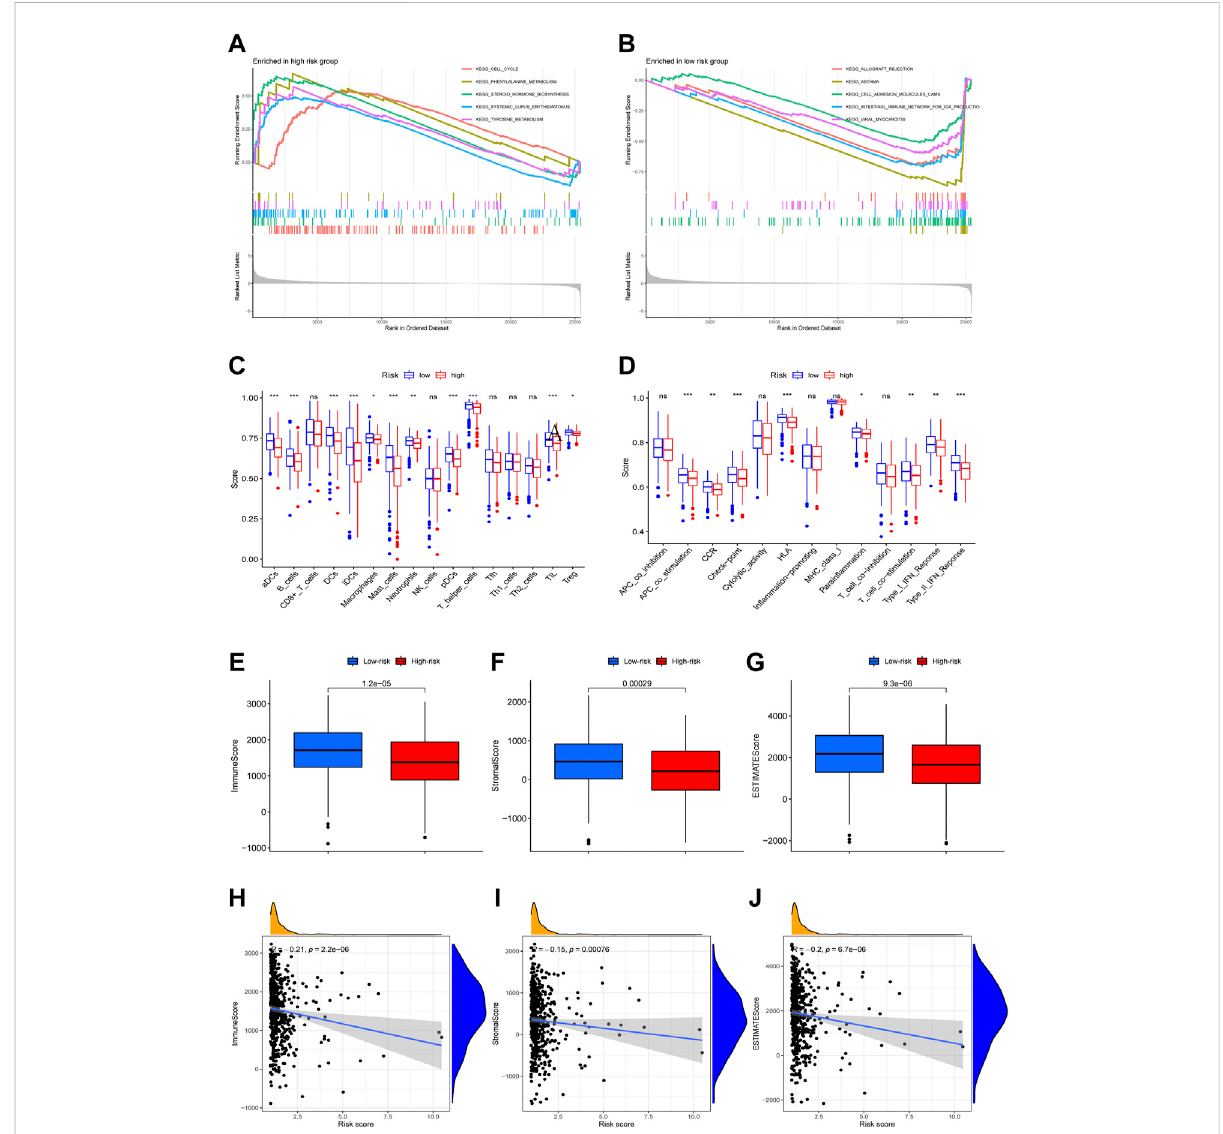
FIGURE 5 GSEA, ssGSEA and ESTIMATE analysis. Gene set enrichment analysis of Kyoto Encyclopedia of Genes and Genomes (KEGG) in high-risk and low-risk groups (A,B) . ssGSEA analysis showed the difference of immune cells and immune function between high-risk and low-risk groups (C,D) . The difference of immune score, stromal score, ESTIMATE score between high-risk and low-risk groups (E – G) . The correlation of immune score, stromal score, ESTIMATE score and risk score (H – J) . (ns, not signi fi cant, * p < 0.05, ** p < 0.01, *** p <